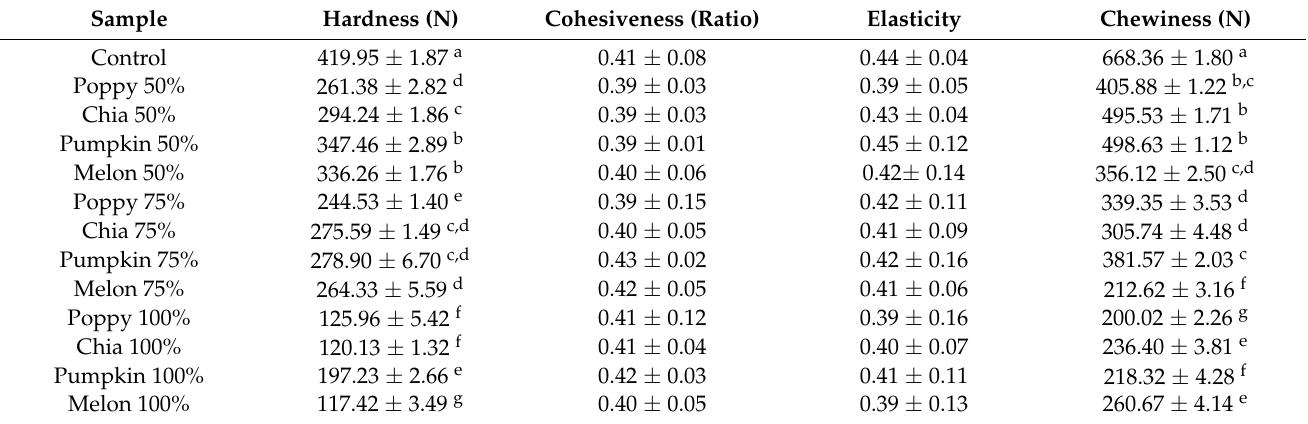
Table 4. Results obtained for the texture parameters analyzed in the different reformulated